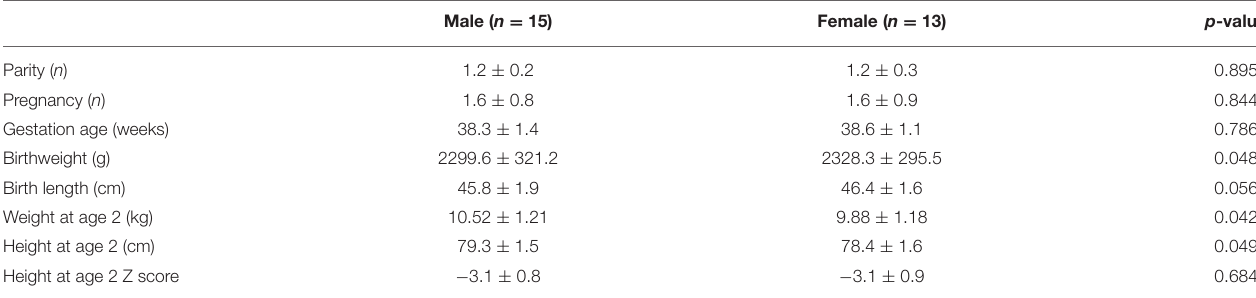
TABLE 1 | The clinical features of 28 full-term small for gestational age (SGA) children with short stature enrolled in this